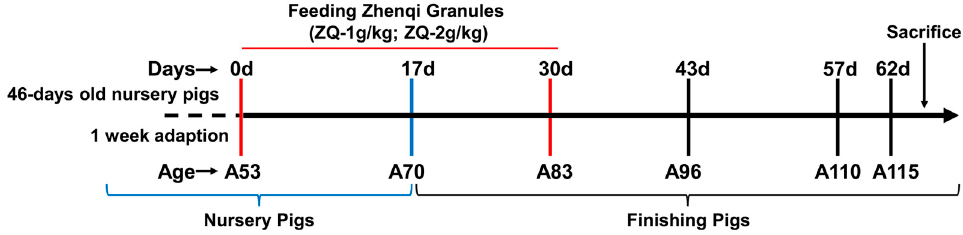
Figure 1. Schematic overview of the experimental design of the study. ZQ, Zhenqi granules. ZQ-1 g, 1 kg standard diet supplemented with 1 g ZQ. ZQ-2 g, 1 kg standard diet supplemented with 2 g ZQ. d, day from the beginning of the experiment. In the following, we use Day to indicate the days of the experiment. A, age of the pigs.